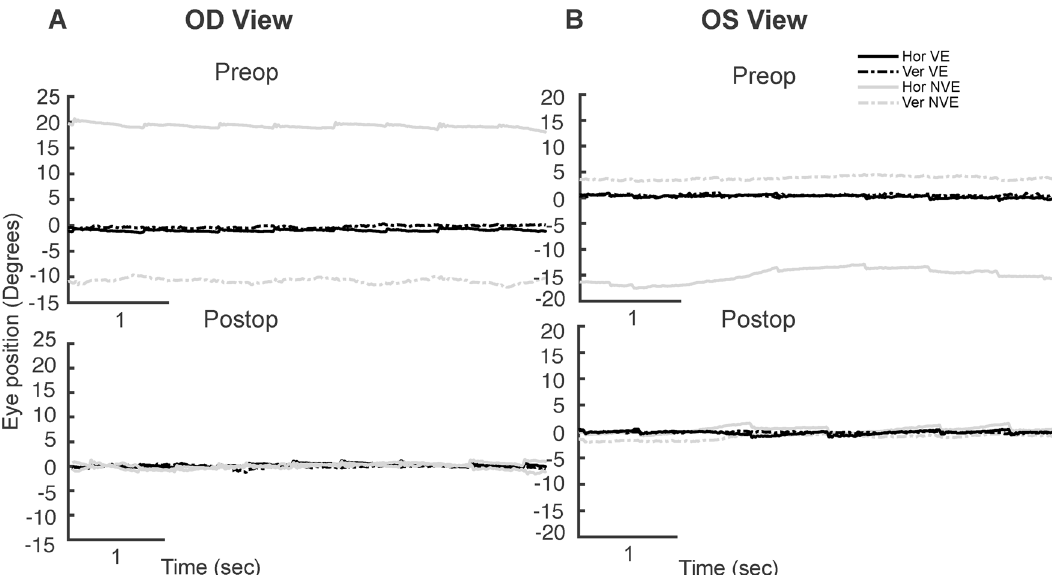
Figure 2. Examples of visual fixation during a 5 s epoch under conditions of monocular viewing from a subject with fusion maldevelopment nystagmus, pre- and post- strabismus repair during right eye viewing (OD viewing— A ) and left eye viewing (OS viewing— B ) pre- and post- strabismus repair. The x-axis represents time and the y-axis represents horizontal (solid line, black: viewing eye, grey: non-viewing eye) and vertical (dotted line, black: viewing eye, grey: non-viewing eye) positions.